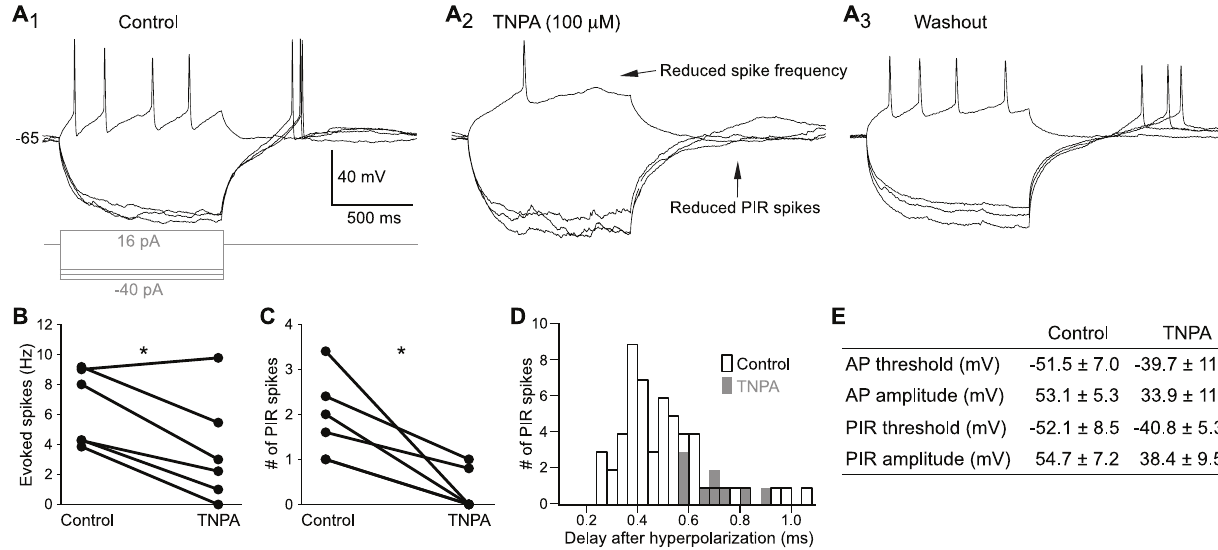
Figure 7. Modulation of striatal neurons by a dopamine D2 agonist. A. Voltage responses of a striatal neuron to 1 s long hyperpolarizing and depolarizing current injections during control (A 1 ), D2 agonist application (TNPA, A 2 ) and washout (A 3 ). B. The number of evoked action potentials is reduced upon application of TNPA, measured here at twice the threshold stimulation. C. The average number of PIR spikes is reduced by TNPA, measured after termination of five consecutive hyperpolarizations in between 2 100 and 2 80 mV. D. The total number of PIR spikes and the time until the spike are reduced by TNPA, measured as in C. E. Table of firing properties before and during TNPA. All values presented as mean 6 SD and differences were significant for all measurements apart from the AP half-width (p , 0.05, student’s t-test). Abbreviations: AP, action potential; PIR, post-inhibitory rebound; TNPA, trihydroxy-N-propyl-noraporphine 123 hydrobromide hydrate .